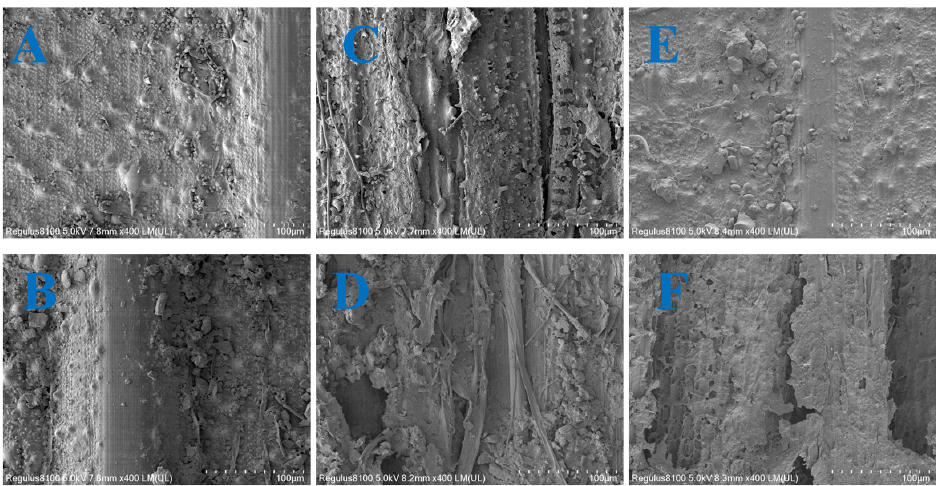
Figure 2. SEM observations of straw materials from control samples and after rumen fluid application at different SMCs (( A) , CK at 30% SMC; ( B) , RF at 30% SMC; ( C ) , CK at 70% SMC; ( D ), RF at 70% SMC; ( E ), CK at 100% SMC; ( F ), RF at 100% SMC) (bar: 0.02 mm).